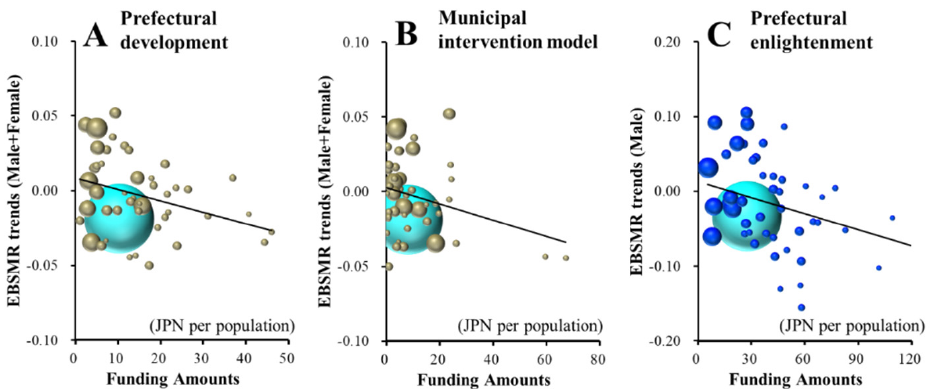
Figure 6. Effects of the amount of funding provided to sub-divisions of EFECBSC on the EBSMR trends of Male+Female ( A , B ) and male ( C ) suicide mortalities of school-aged population were anal- ysed by forward multiple regression analysis. Ordinates indicate EBSMR trends for suicide mortality among those over 10 years old between 2009 and 2018, and abscissas indicate the amount of funding provided to EFECBSC sub-divisions (JPY per population). Light blue, grey and blue spheres indicate national, Male+Female and male EBSMR trends and population sizes, respectively. Black lines indi- cate the regression lines of significantly positive (decreases suicide mortality) factors. Male+Female EBSMR trends of school-aged populations = − 0.0008 × (prefectural development programme of leaders/listeners) − 0.0006 × (municipal intervention model programme) + 0.015. Male EBSMR trends of school-aged populations = − 0.0006 × (prefectural enlightenment programme) +